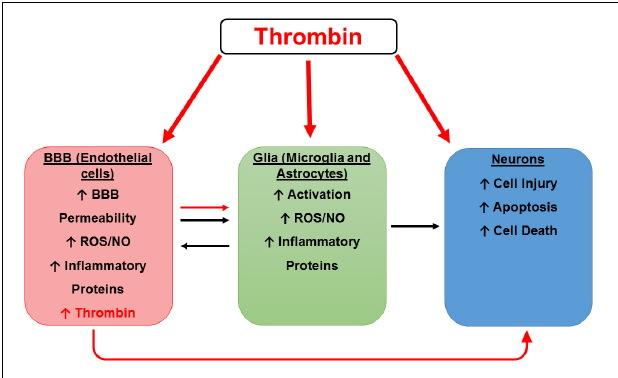
FIGURE 2 | Hypothetical scheme for thrombin as a mediator of cerebrovascular activation, neuroinflammation, and neurodegeneration. A hypothetical scheme for thrombin as a mediator of cerebrovascular activation, neuroinflammation, and neurodegeneration. Thrombin can cause neuronal injury directly and indirectly by activation of endothelial cells (ECs) and glia. Thrombin can act on ECs of the blood-brain barrier (BBB) to cause endothelial activation characterized by increased permeability and an increase in reactive oxygen species (ROS), nitric oxide (NO), and inflammatory proteins including thrombin. These toxic vascular-derived products can injure neurons as well as activate neighboring glial cells to release noxious mediators which in turn cause neuronal